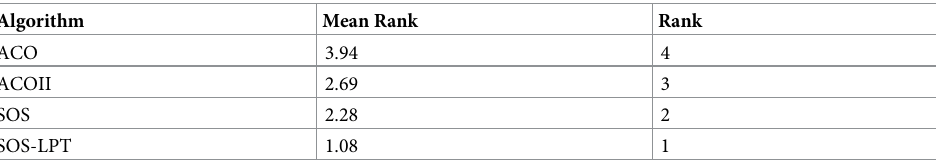
Table 7. Friedman’s rank test for the 180 instance combination of the benchmarked problem of ACO, ACOII, SOS, and SOS-LPT using their average C max values.